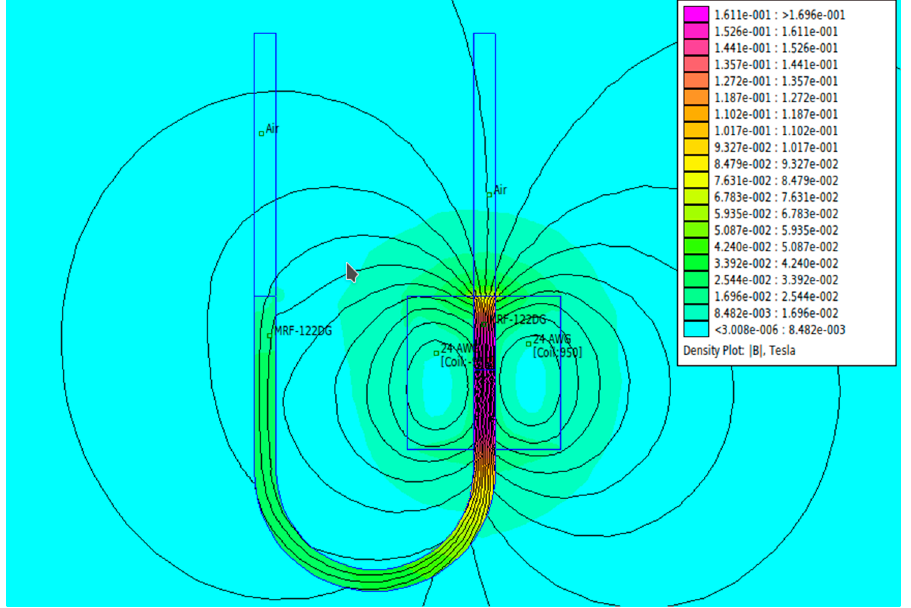
Figure 4. The FEMM simulation results: the magnetic field conditions in the U-type channel when a current of 1.5 A is applied.